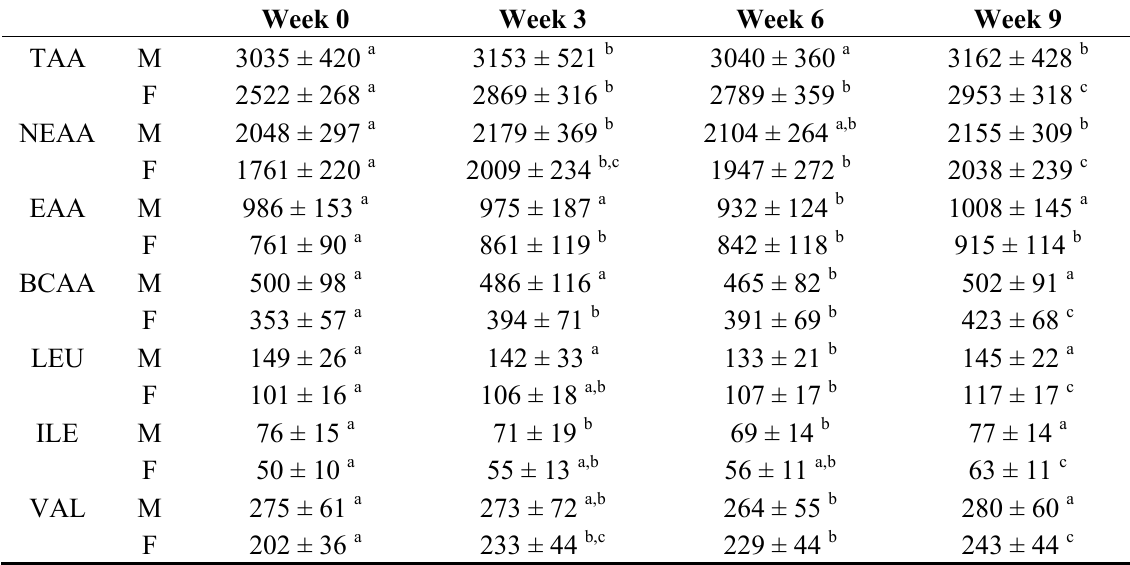
Table 3. Plasma amino acid (µmol∙L −1 ) concentrations during basic combat training in male and female recruits 1,2,3